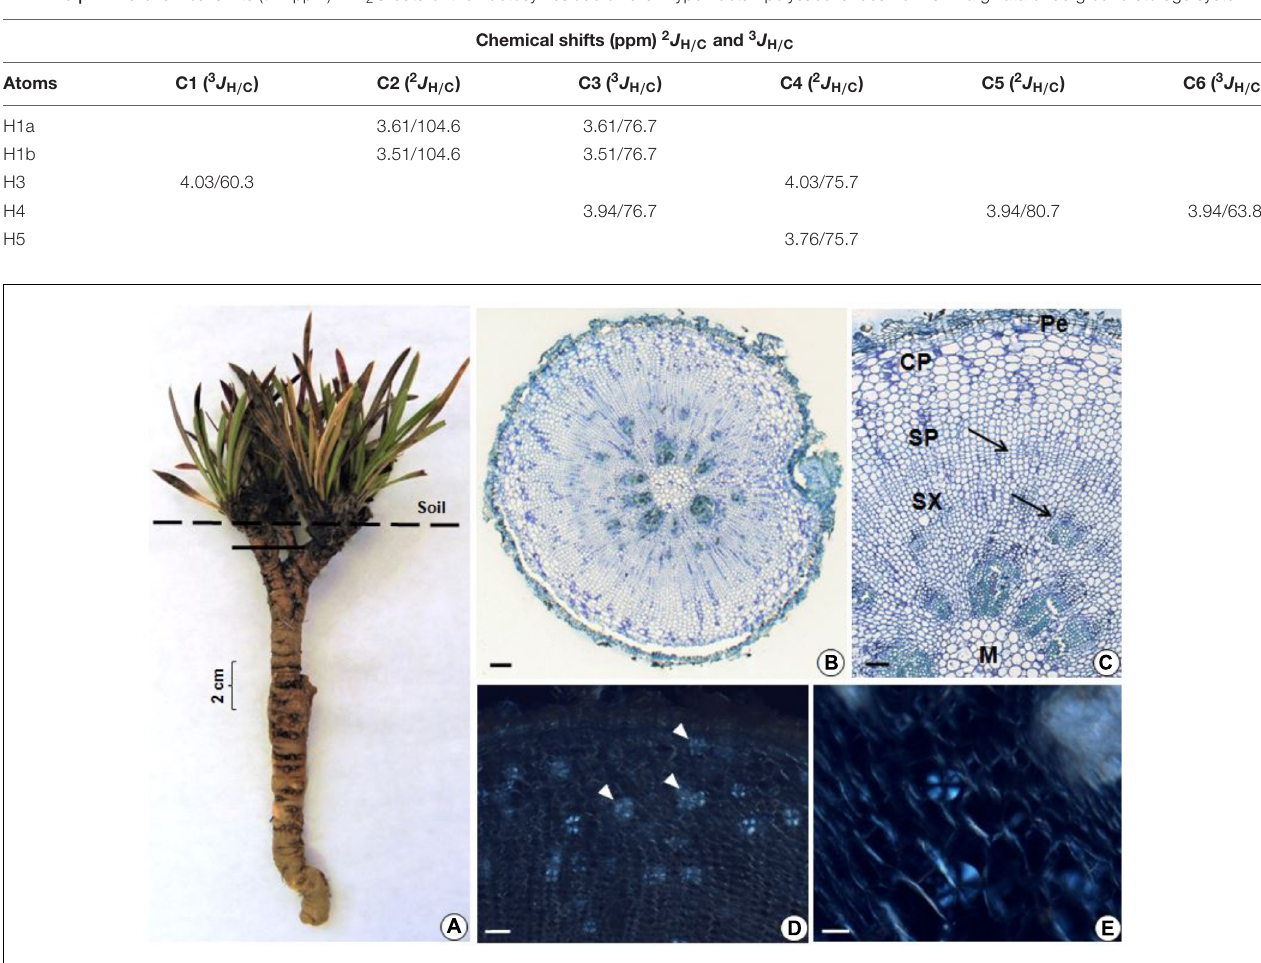
FIGURE 4 | (A) General view of G. marginata ; continuous line indicates the sectioned region. (B–E) Transverse sections of the stem. General (B) and detailed (C) view, showing periderm (Pe), cortical parenchyma (CP), secondary phloem (SP), secondary xylem (SX), cambia (arrows) and medulla (M). Fructan spherocrystals (arrowheads) visualized under polarized light in the parenchyma cells of the cortex, in the secondary phloem and xylem (D) and medulla (E) . Scale bars: 200 µ m (B) , 100 µ m (C,D) , and 50 µ m (E)